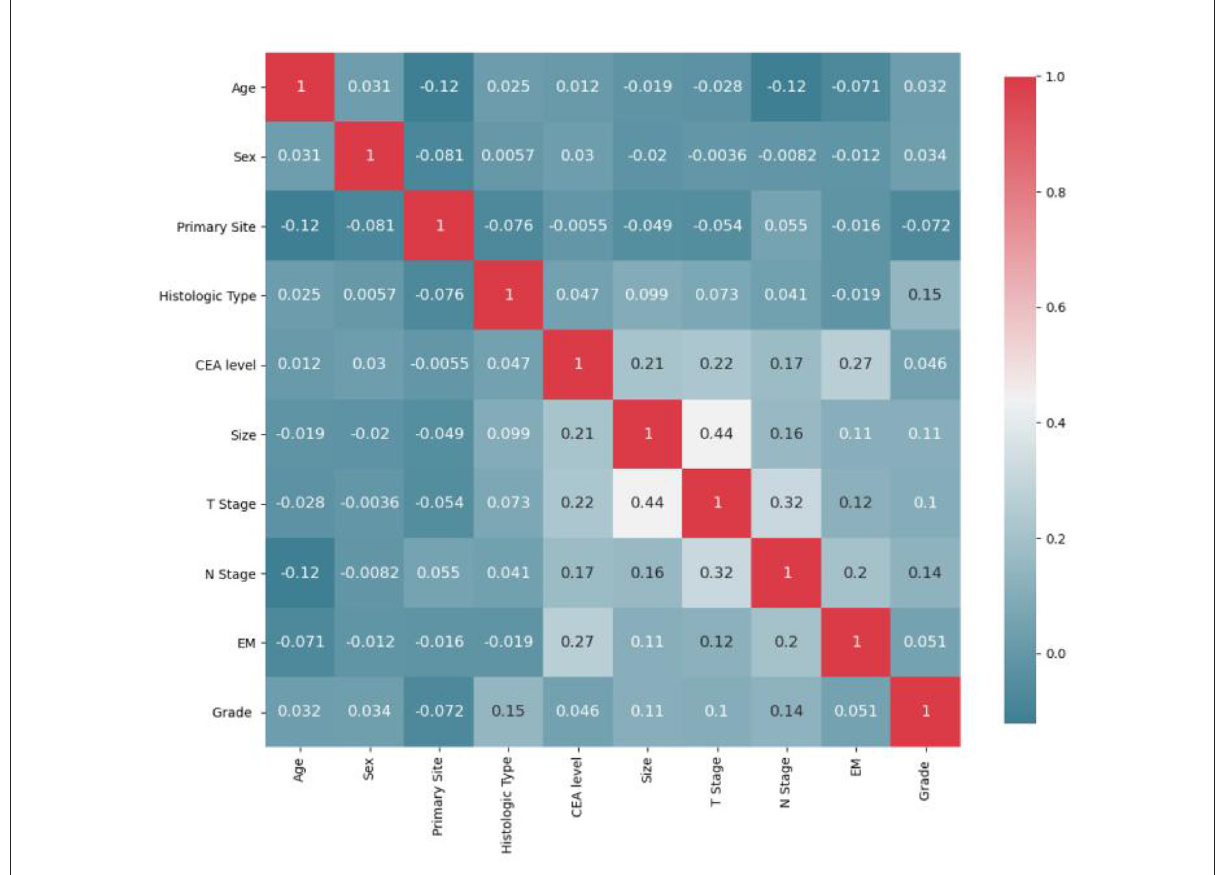
FIGURE2 Feature correlation heatmap after initial preprocessing.